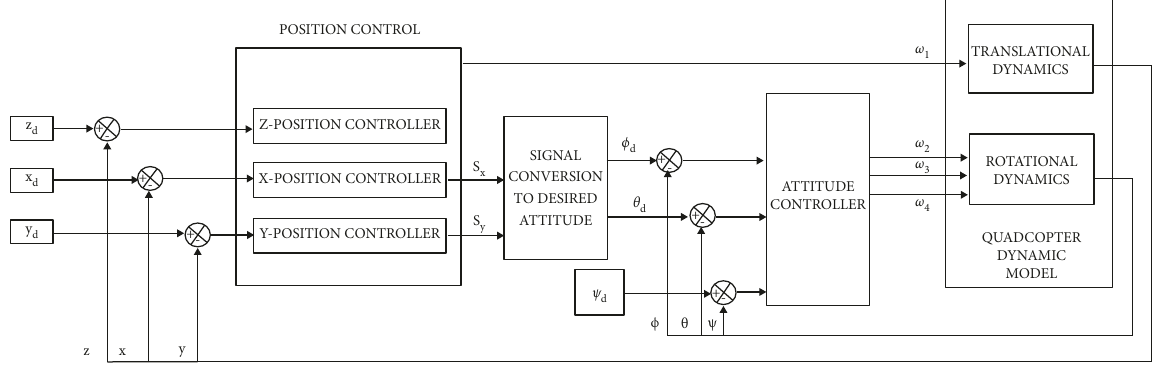
Figure 3: Control